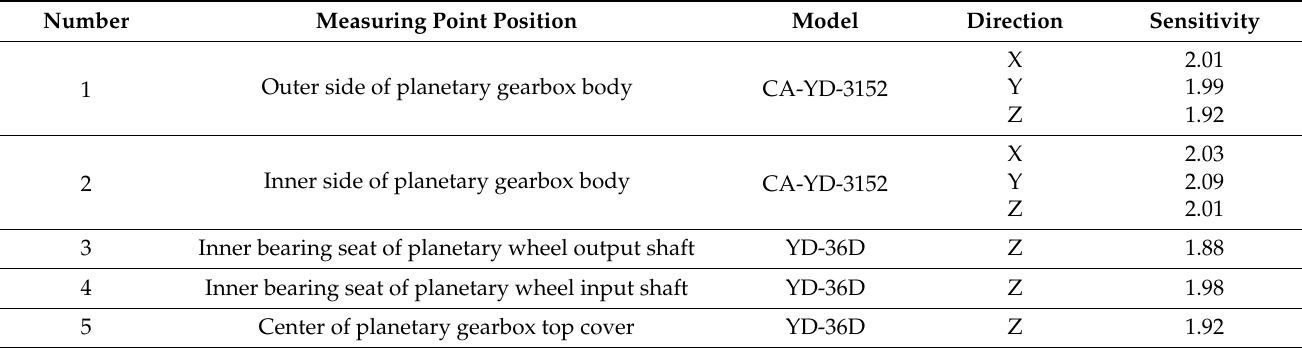
Table 1. The acceleration sensor information used in the